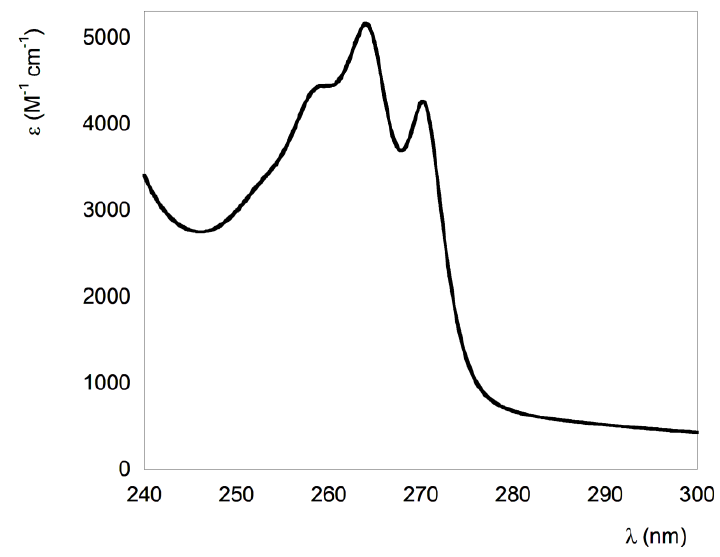
Figure 3. UV spectrum of 1 in CH 2 Cl 2 solution.